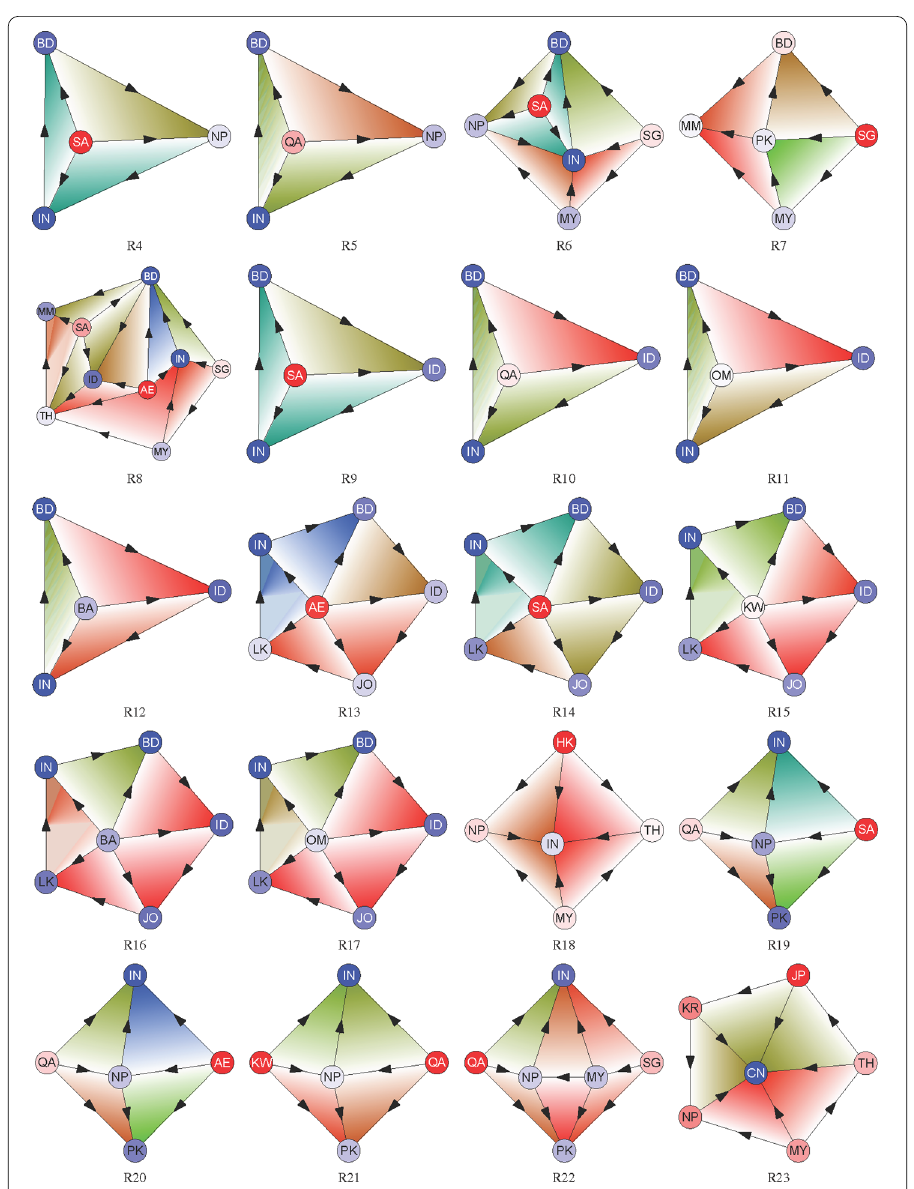
Figure 14 Spherical patterns within the Asian migration and Remittance networks continued. 2-cycle generators for the 2015 Asian net migration (M1-M37) and remittance (R1-R42) networks